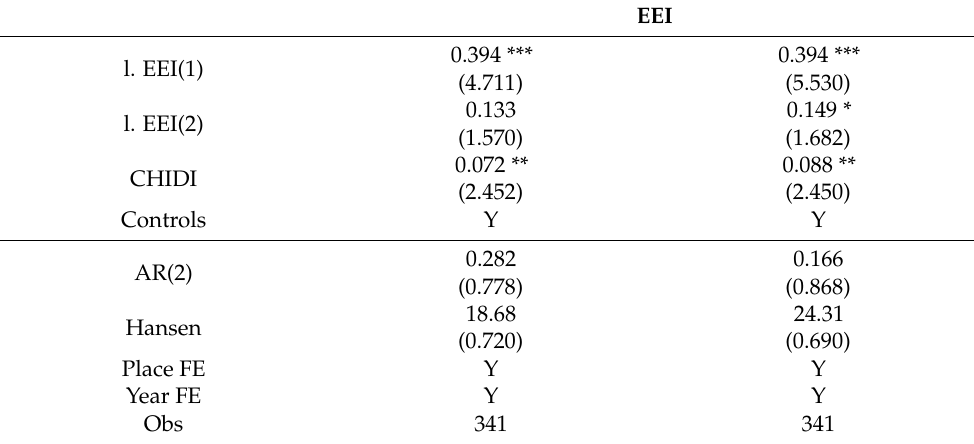
Table 7. System GMM